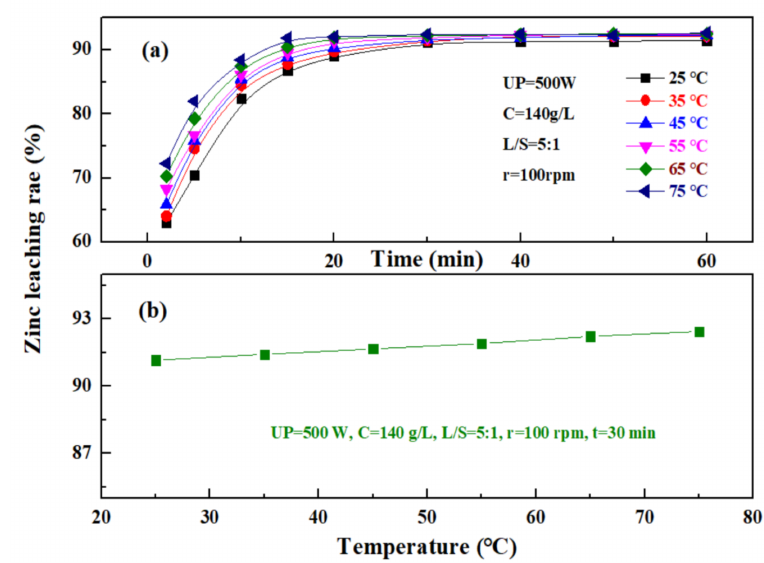
Figure 10. Effect of temperature on zinc leaching rate: ( a )—different times; and ( b )—30